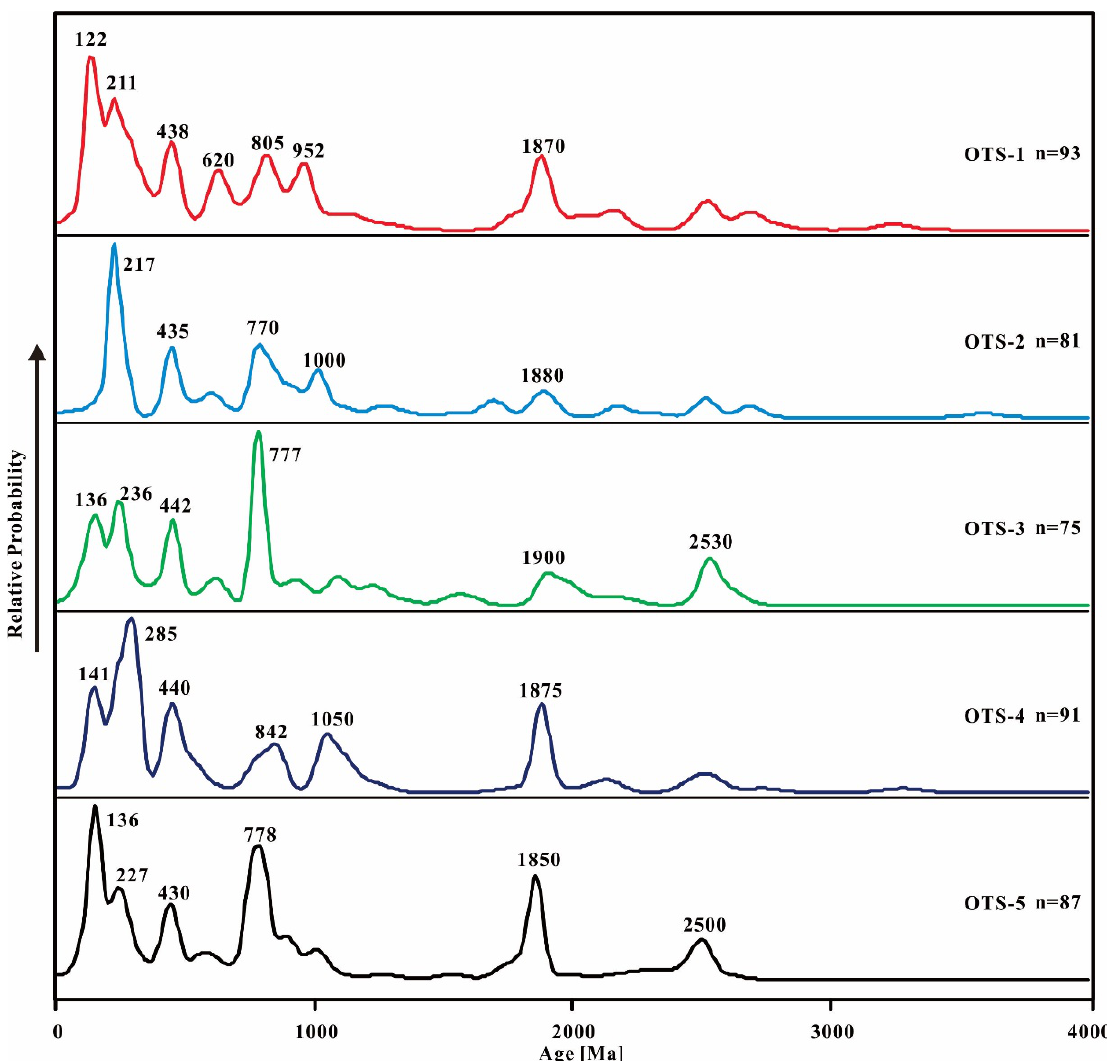
Figure 4. Kernel density estimation (KDE) plots for detrital zircon U-Pb ages of OTS-1 to OTS-5 in H4-S2. Please refer to Table S1 for detailed data. The results of OTS-1 and OTS-2 are reprocessing of the previous data [47]. The values of major age peaks are marked in this figure.